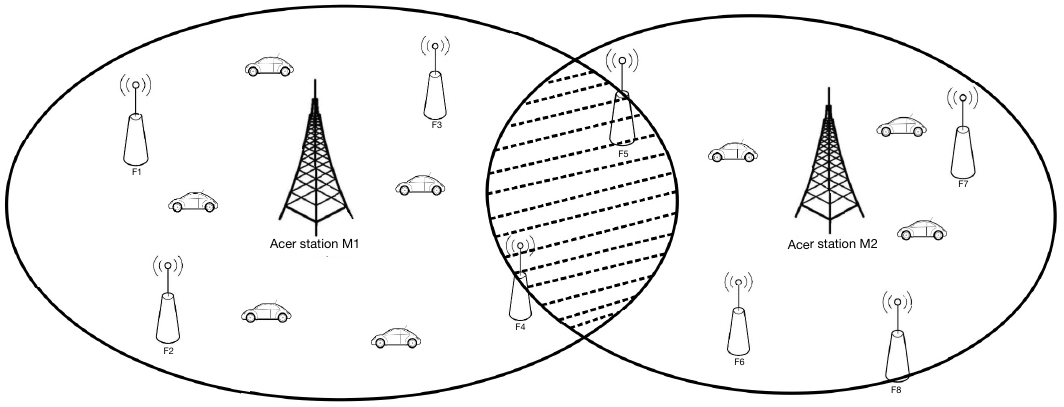
Figure 1. System